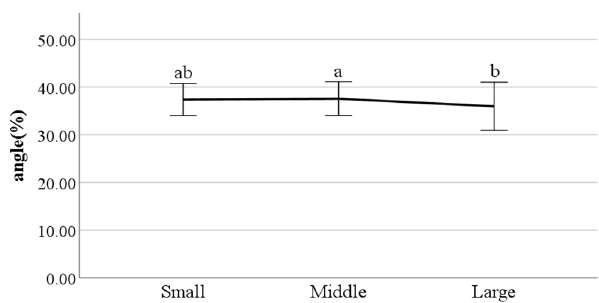
Figure 24. The ratio of swing phase of right foot (F value: 3.17, DF: 2, p -value: 0.04).